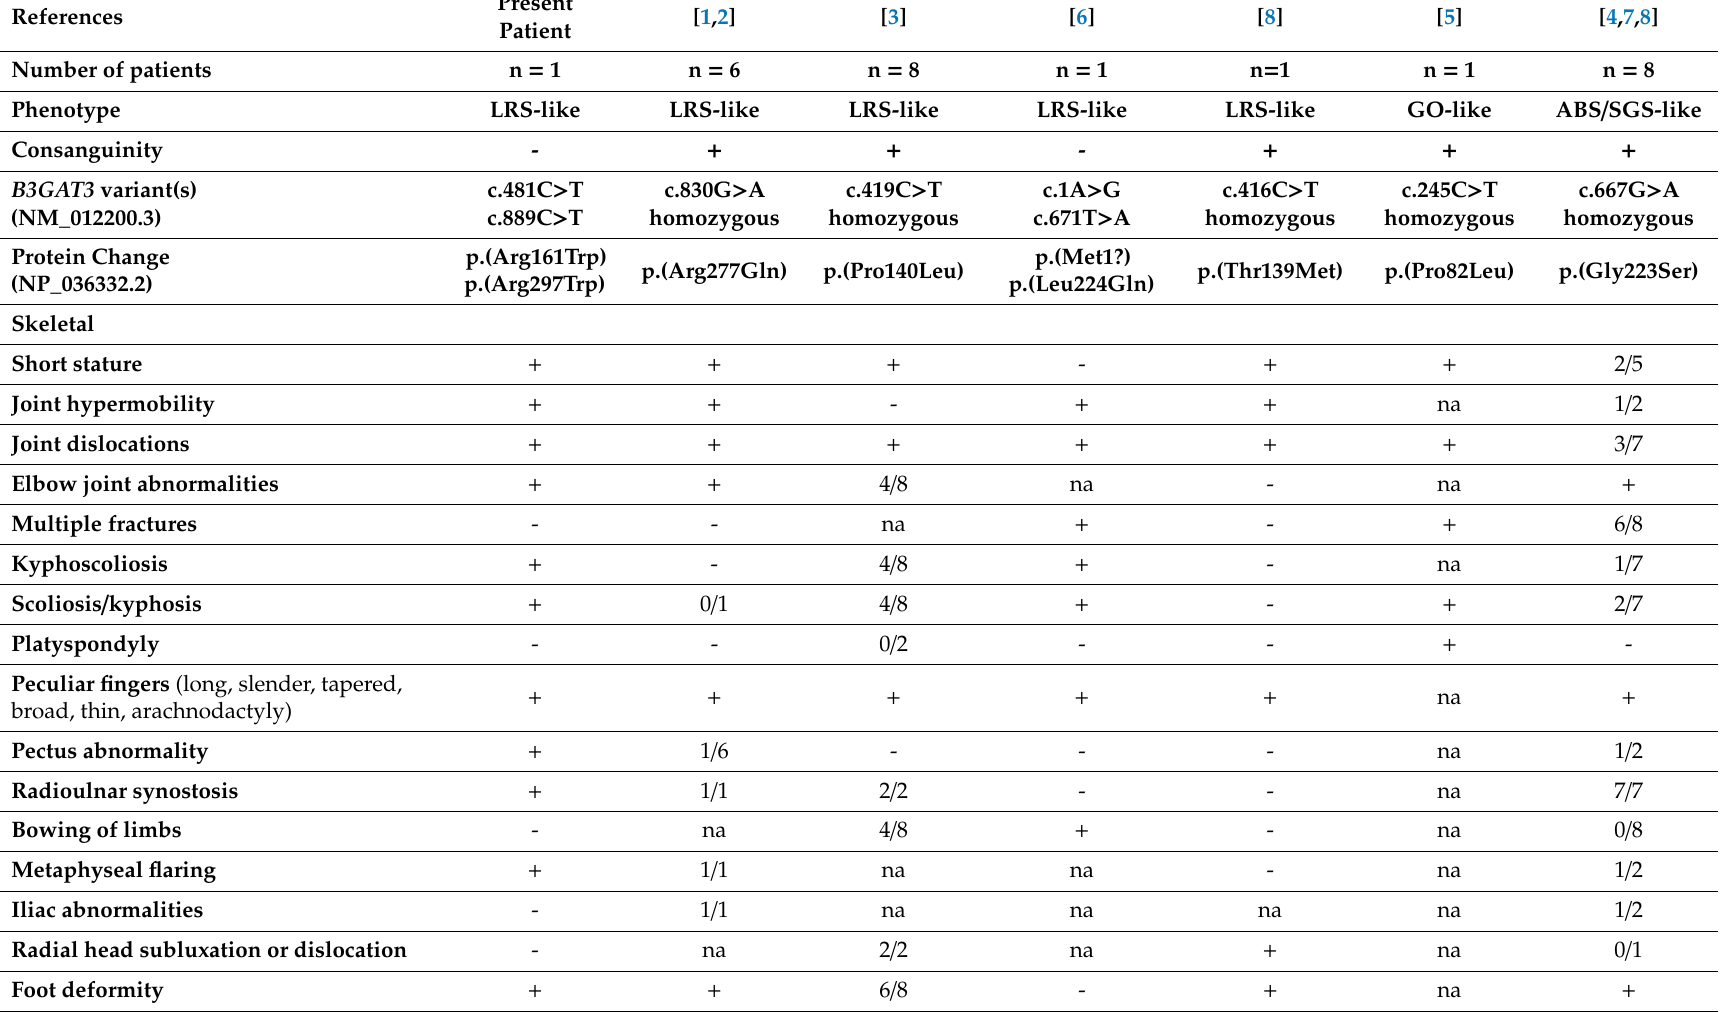
Table 2. Summary of clinical features of all patients with B3GAT3